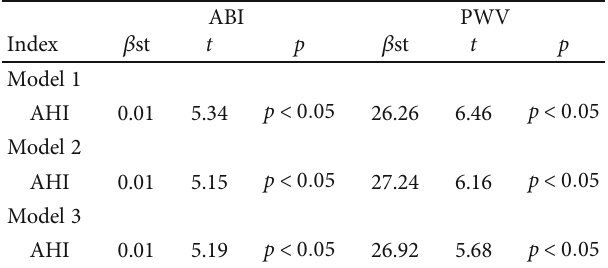
Table 3: Multiple stepwise linear regression results between AHI level with ABI and PWV.